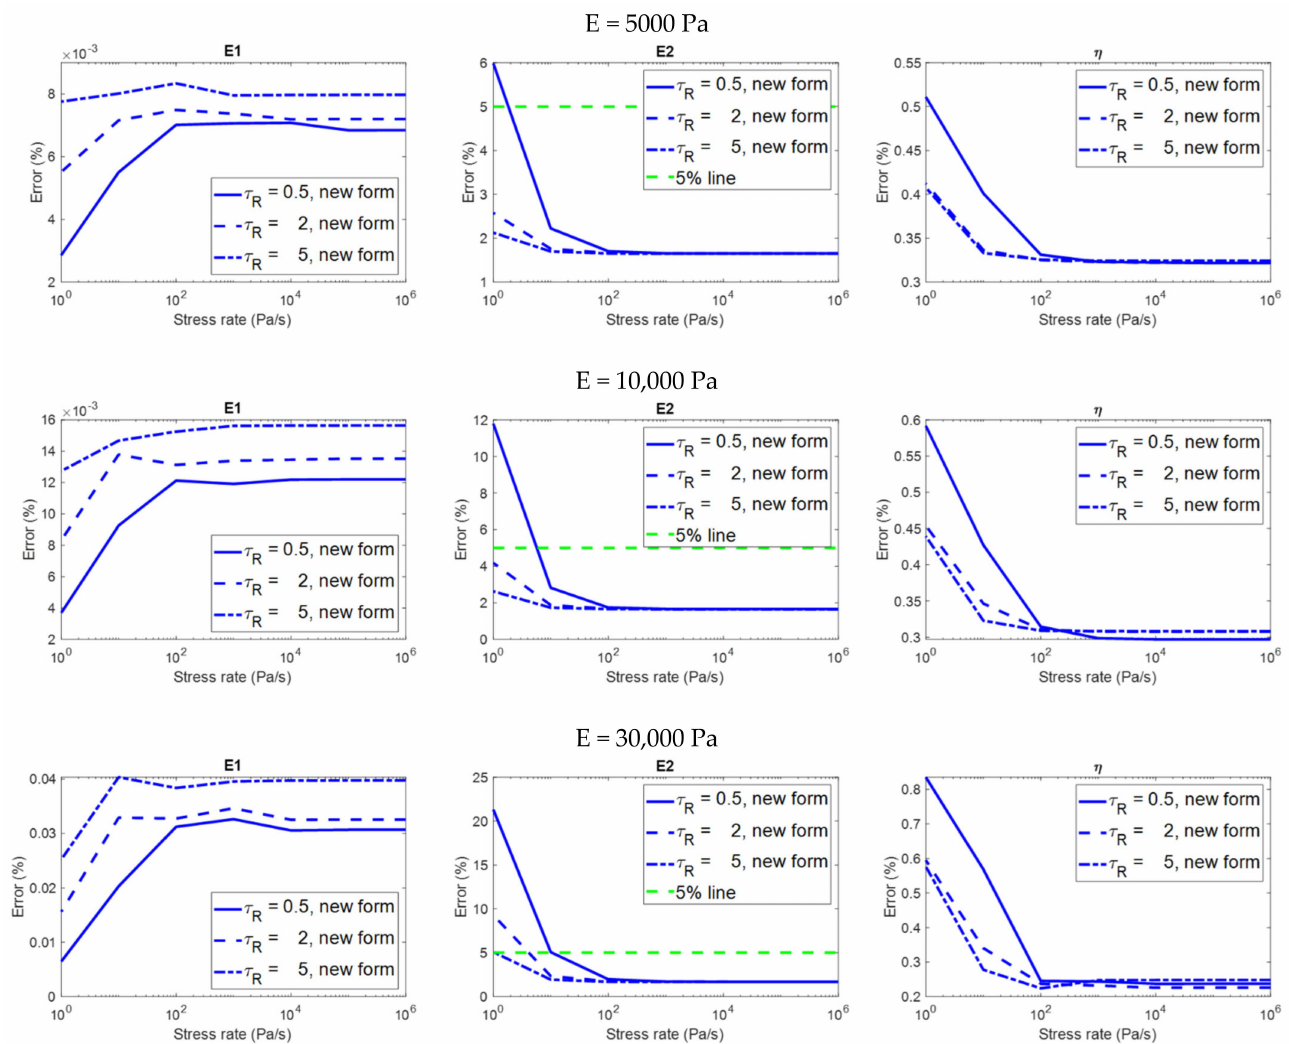
Figure 9. The relationship between the stress rate and the error in the evaluation of the viscoelastic properties on different material models in the creep simulation, analyzed using the newly − introduced constitutive equation derived with finite loading